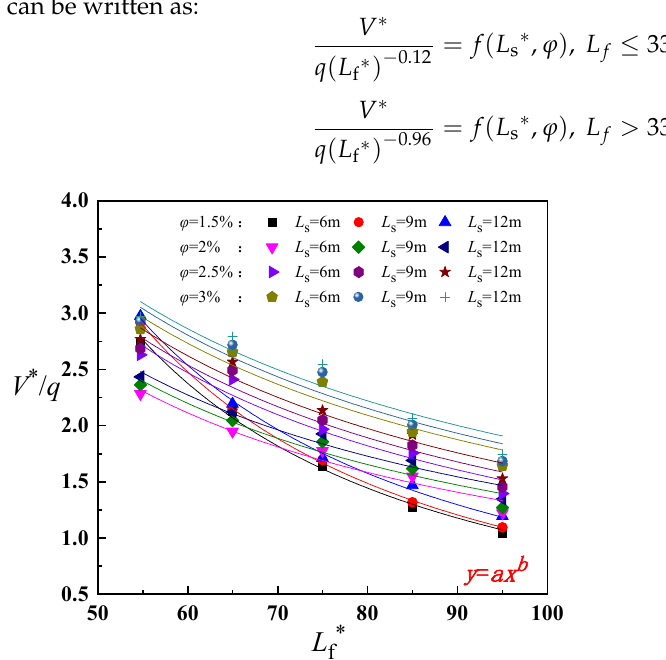
Figure 8. Dimensionless relationship between inlet air velocity and fire source location ( L f > 330). Table 2. Fitting coefficients of the dimensionless relation between inlet air velocity and fire source location ( L f ≤ 330).